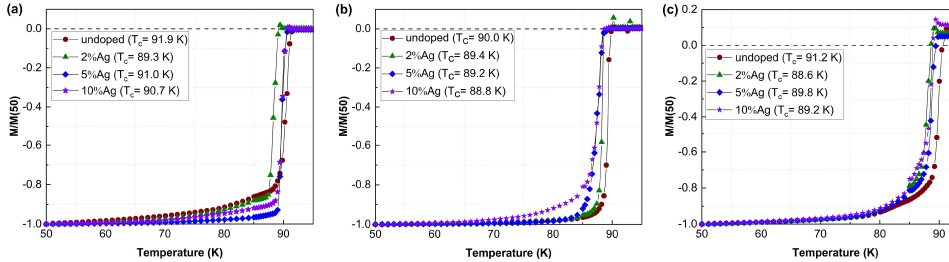
Figure 5. Temperature dependence of the normalized magnetization for undoped and Ag−doped YBCO films on ( a ) STO, ( b ) IBAD−MgO, and ( c ) RABiTS . YBCO films on ( a ) STO, ( b ) IBAD − MgO, and ( c ) RABiTS.